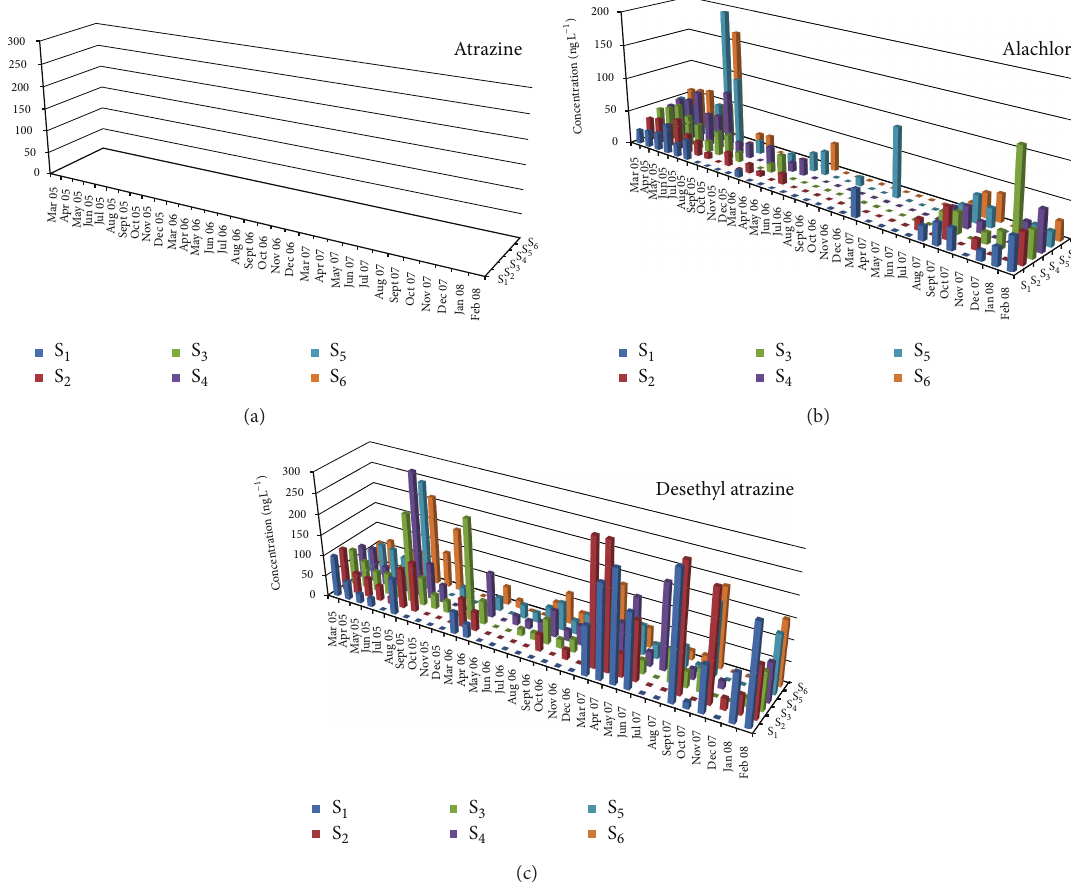
concentrations with significant differences ( 𝑃 < 0.05 ) among upper (S 1 –S 3 ) and lower (S 4 –S 6 ) sampling stations. Diazinon had the highest mean concentration (S 5 : 26.3 ± 3.48 ng L −1 ) and dimethoate the lowest (S 1 : 2.29 ± 0.55 ng L −1